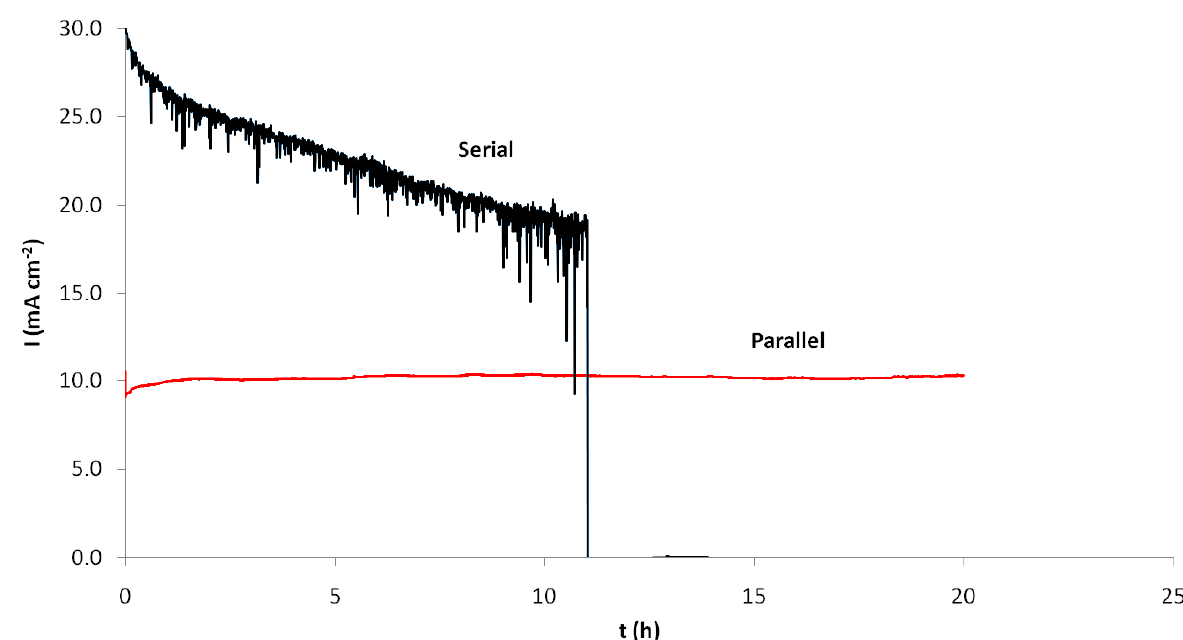
Figure 9. Chronoamperometric measurements of two-cell